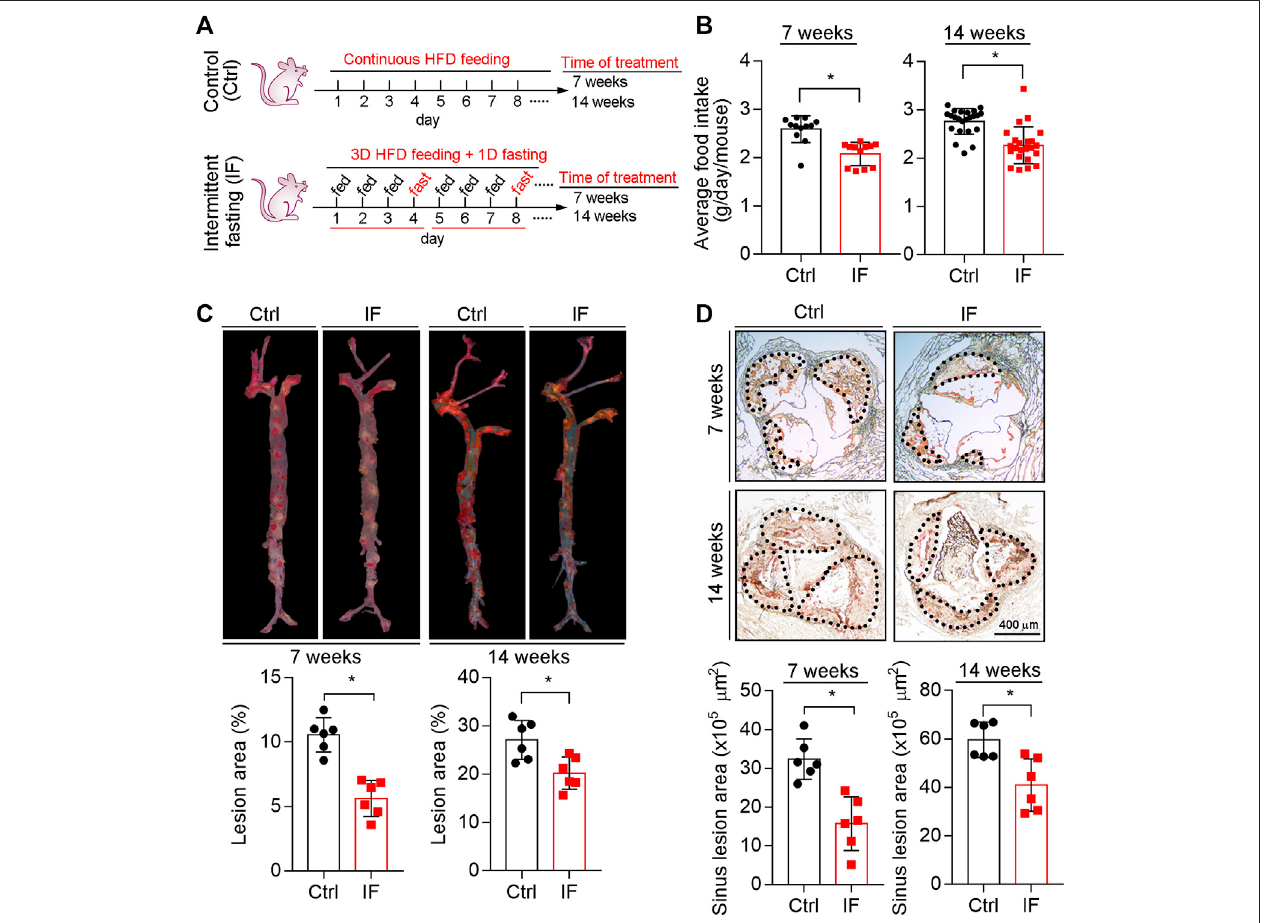
FIGURE 1 | Inhibition of atherosclerosis in LDLR − / − mice by intermittent fasting treatment. (A) (experimental design): LDLR − / − mice were divided into four groups ( n (cid:1) 6),andreceivedthefollowingtreatmentfor7or14 weeks:Controlgroups,micewerefedHFDadlibitum;intermittentfasting(IF)groups,micewerefedHFDincycles of3-dayHFDfeedingand1-dayfasting. (B) Thefoodintakeineachcyclewasdeterminedandcalculatedasthedailyaverageintakepermouse.* p < 0.05[ n (cid:1) 12(cycles) in 7 week groups, n (cid:1) 23 (cycles) in 14 week groups]. (C,D) Lesions in the en face aortas (C) or sinus lesions in the aortic root (D) were determined by Oil Red O staining followed by quantitative analysis. Lesions in the en face aortas were expressed as a percentage of the whole aorta area, and sinus lesions were expressed as μ m2. * p < 0.05, ( n (cid:1) 6). Ctrl: control; IF: intermittent fasting.